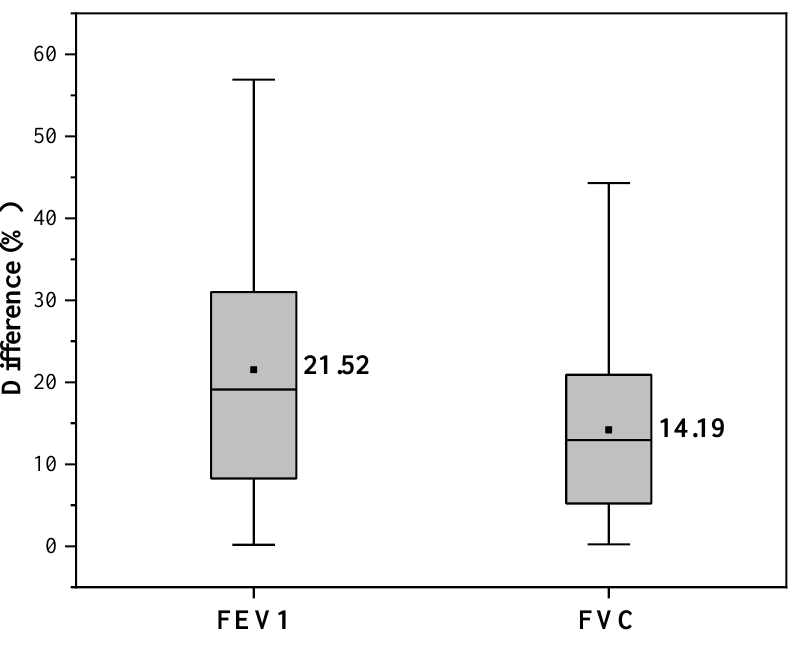
Figure 11. Box plot of error percentages of deep learning.